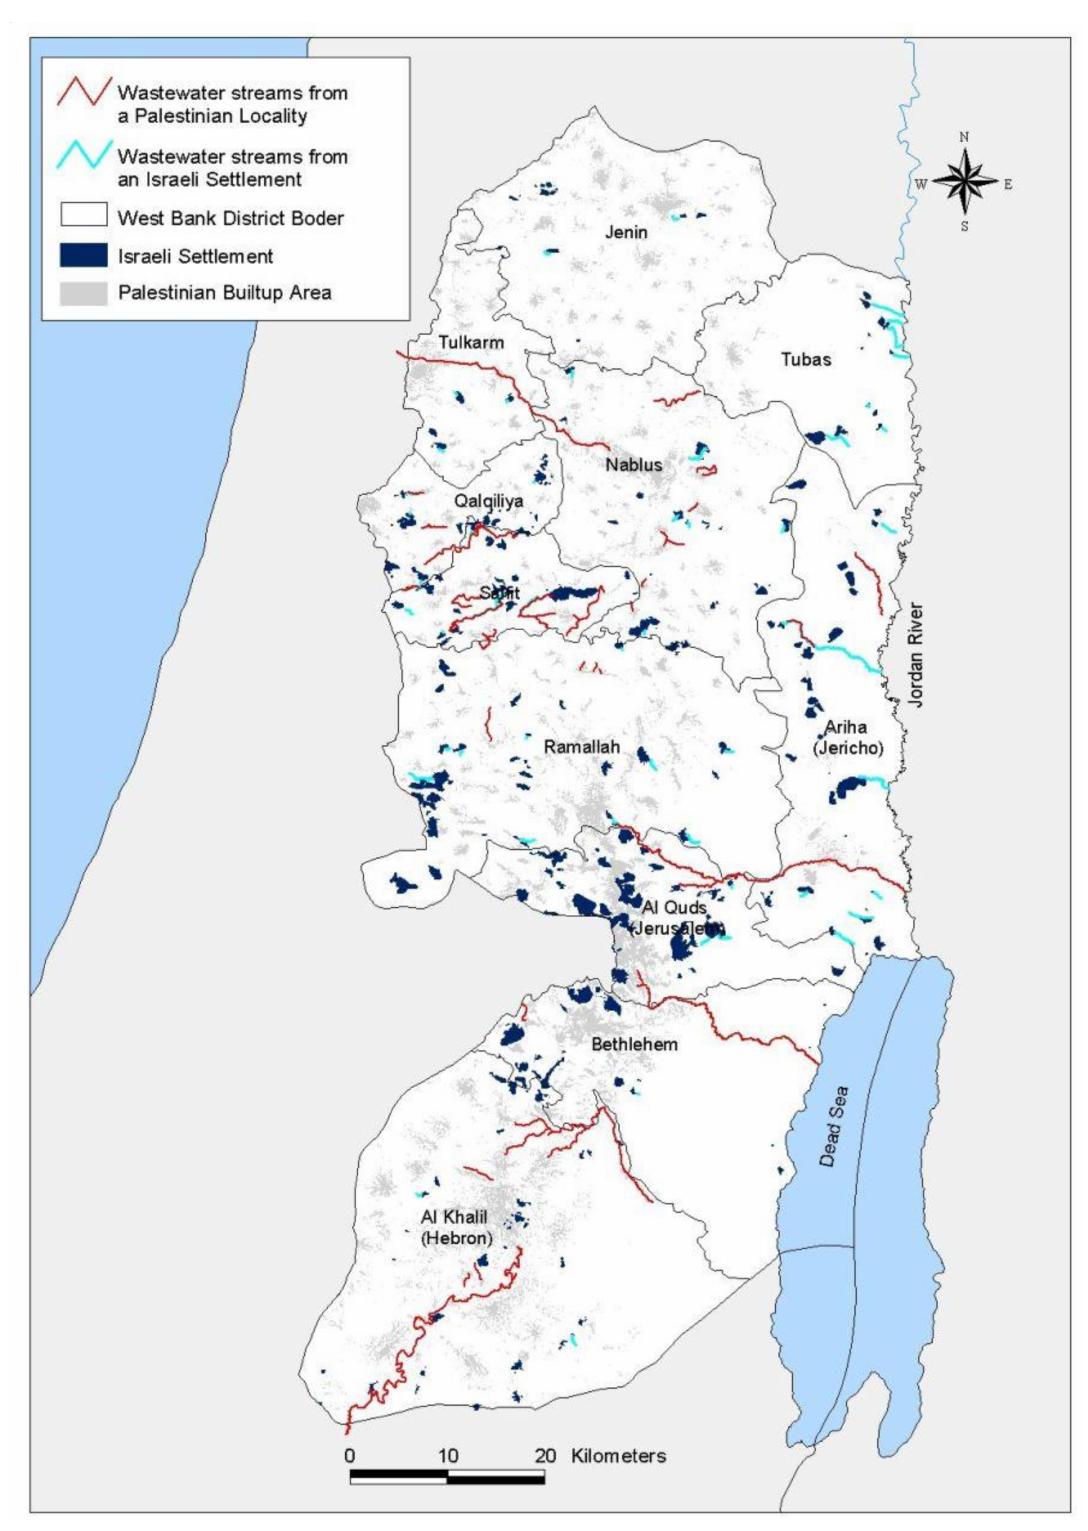
Figure 2. Wastewater streams from Palestinian location and Israeli settlements (ARIJ,